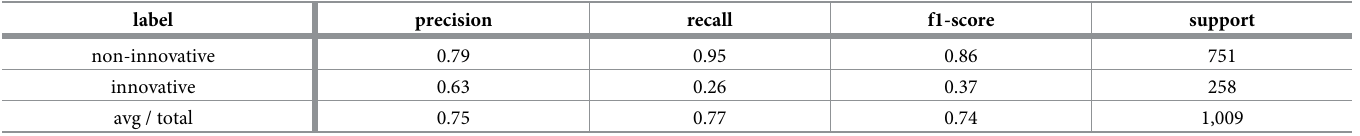
Table 7. Product innovator classification report for alternative data test set C. label